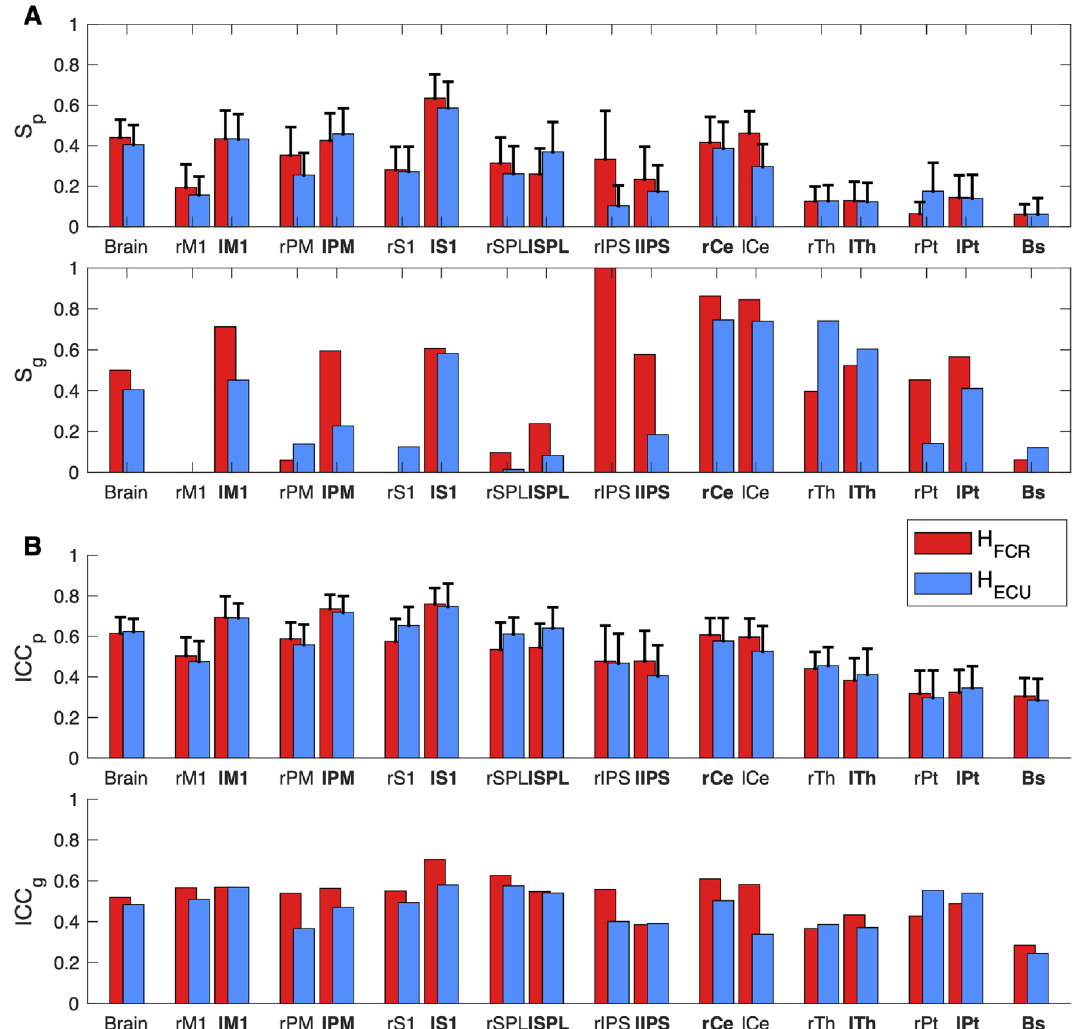
Figure 4. Test-retest reliability scores obtained in the whole brain and in the selected ROIs for the group level (g) and participant-specific (p) analyses. ( A ) Sørensen-Dice index, ( B ) Intraclass correlation coefficient. For ICC S p and p , bar height indicates the mean value of the respective metric measured in all participants, with the error bars showing the 95% confidence intervals. Brain regions marked in bold are those regions were activation is